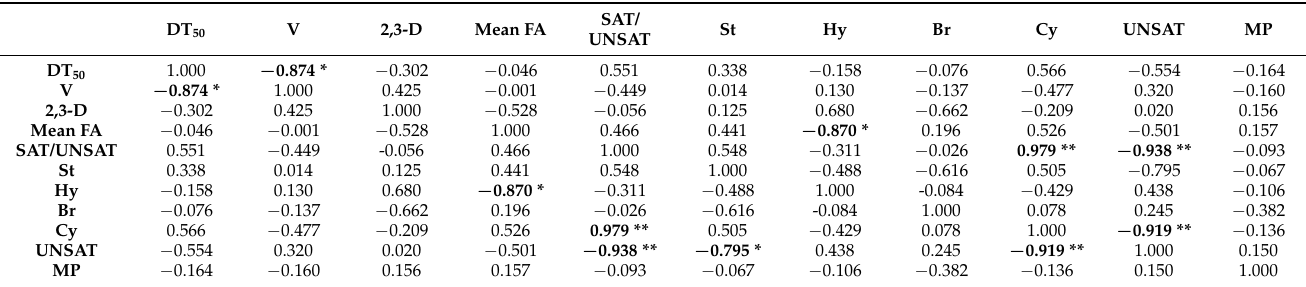
Table 5. Pearson’s correlation matrix for phenol degradation kinetic parameters, catechol 2,3- dioxygenase activity, membrane permeability, and FAME indexes for S. maltophilia KB2 under suboptimal growth conditions.